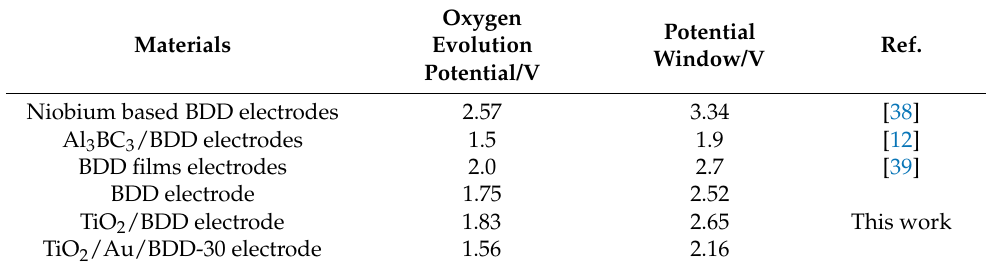
Table 2. The comparison of the BDD modified